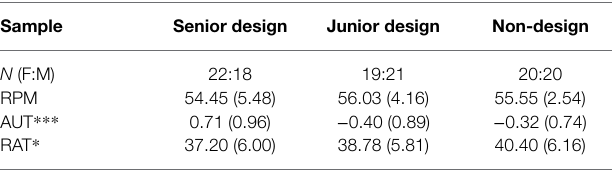
TABLE 1 | Number of males and females in the senior design, junior design, and non-design groups, and descriptive information about the study variables in each